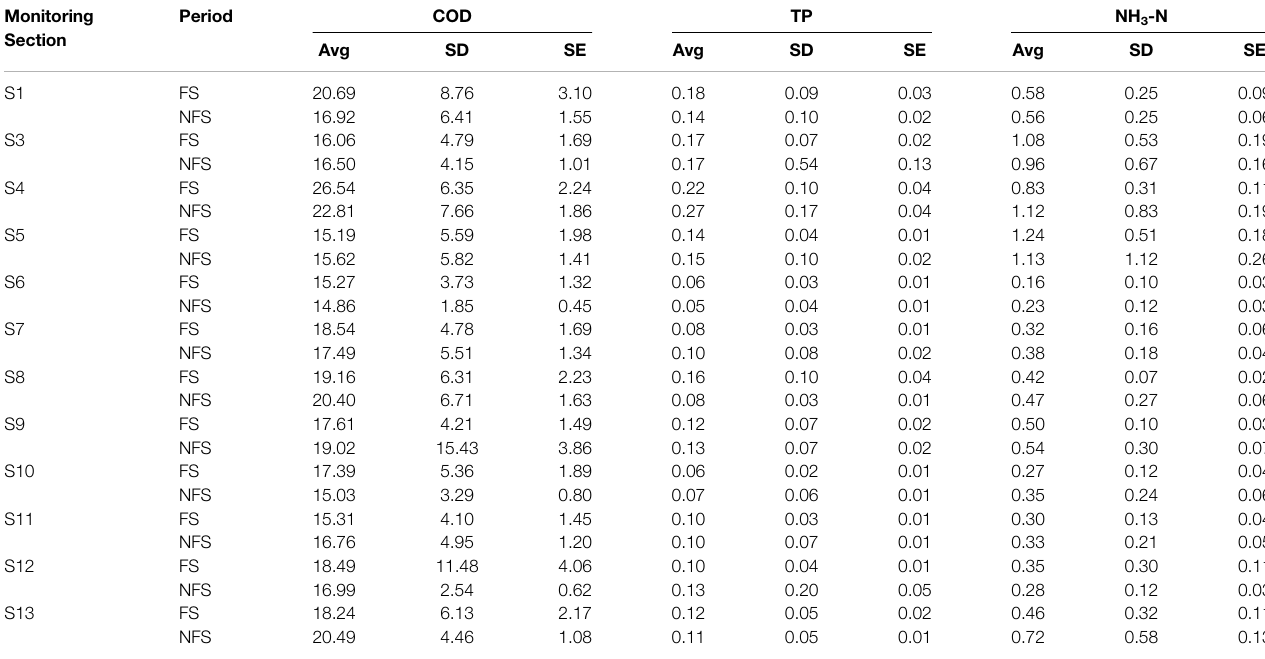
TABLE 3 | Variations in the water quality parameters for the study area from 2017 to 2019 (Avg: Average; SD: Standard deviation, SE: Standard error, FS: Flood season, NFS: Non- fl ood season). Monitoring Section